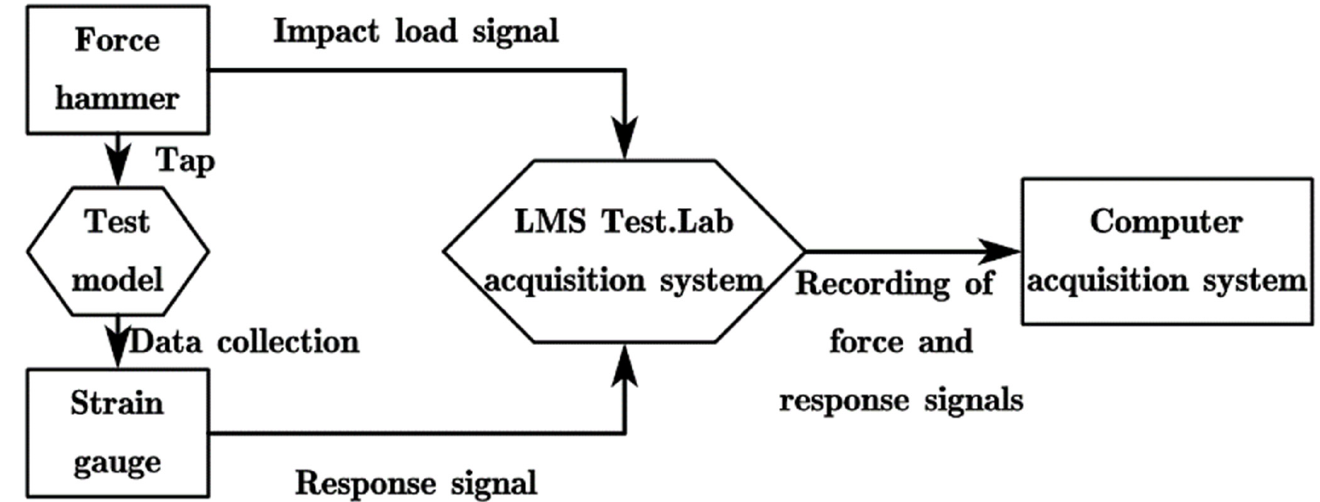
Figure 3. Impact load test system of weapon pylon.